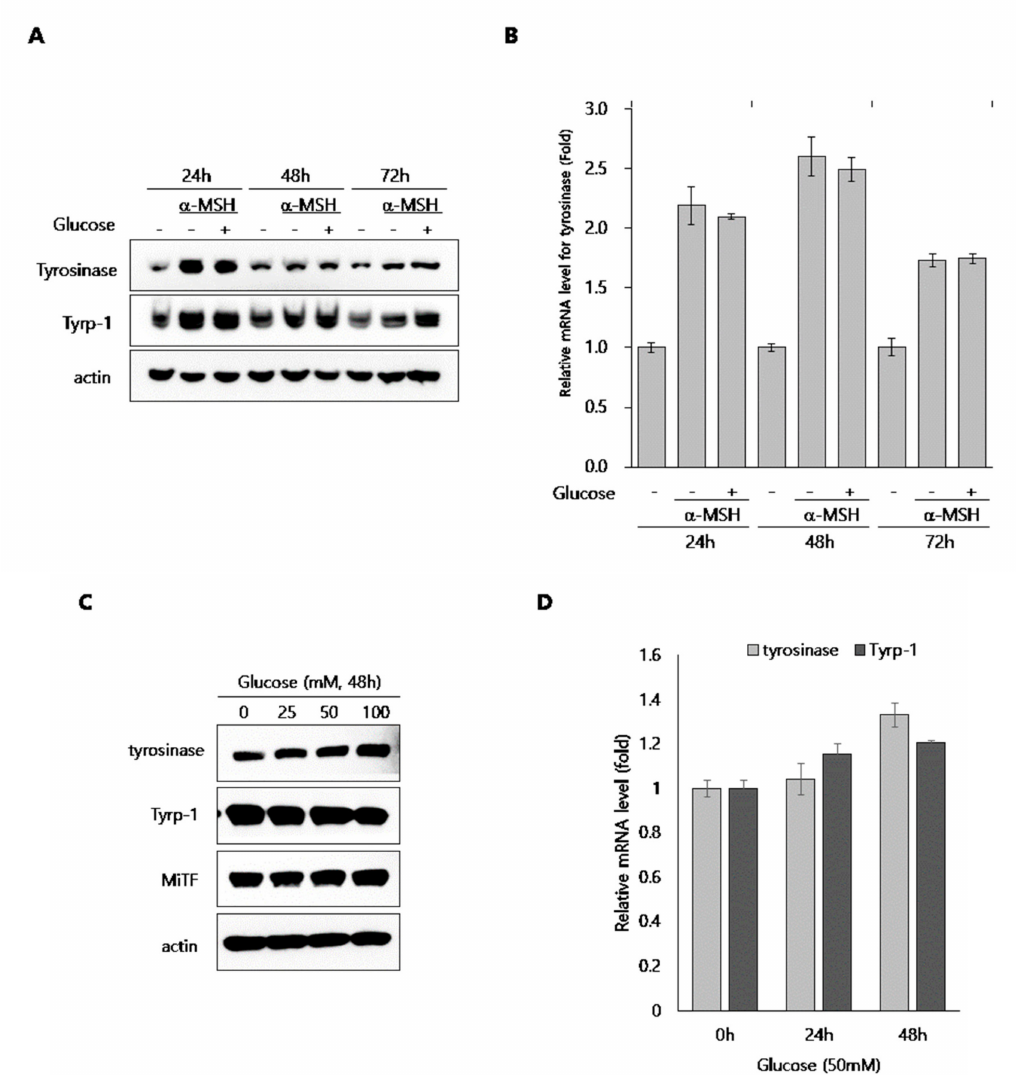
Figure 3. E ff ect of glucose on the expression of melanogenic proteins in B16 cells and NHMs. ( A , B ) B16 cells were treated with α -MSH for the indicated time in the presence or absence of 20 mM glucose. Then, Western blot ( A ) and qRT-PCR ( B ) assays were performed. ( C ) NHMs were treated with the indicated concentrations of glucose for 48 h. Then, the Western blot assay was performed. ( D ) NHMs were treated with the indicated time in the presence of 50 mM glucose. Then, qRT-PCR assays were performed. Data are expressed as the mean ± SD of at least three independent